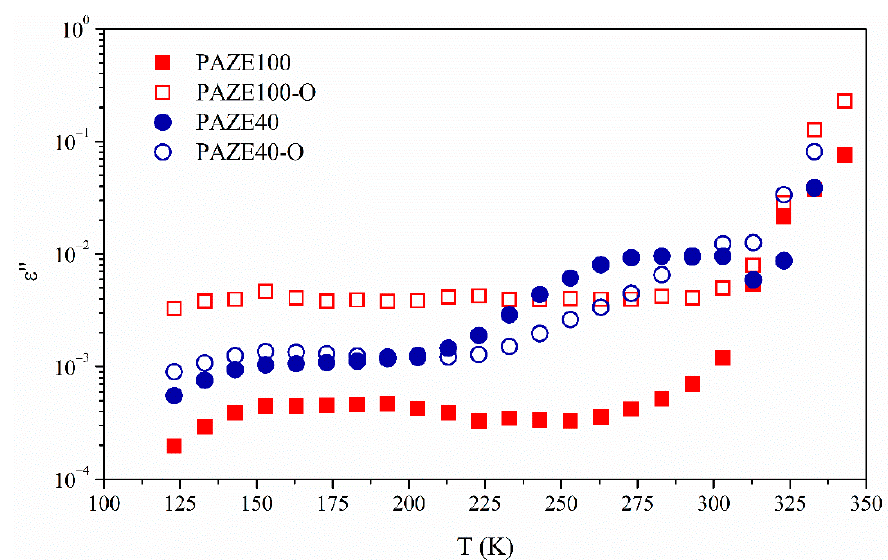
Figure 10. Comparative isothermal curves at 1 kHz of imaginary part of dielectric permittivity of ( b ) unoriented and oriented PAZE100 and PAZE40.